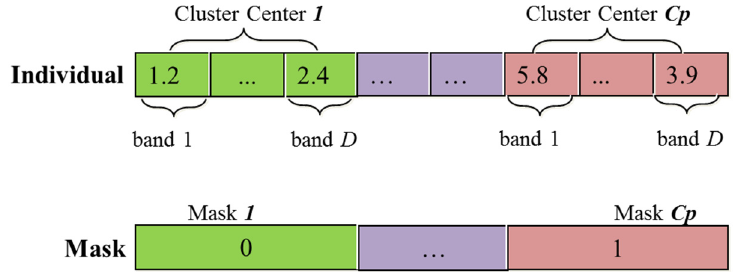
Figure 6. The encoding strategy in automatic clustering.